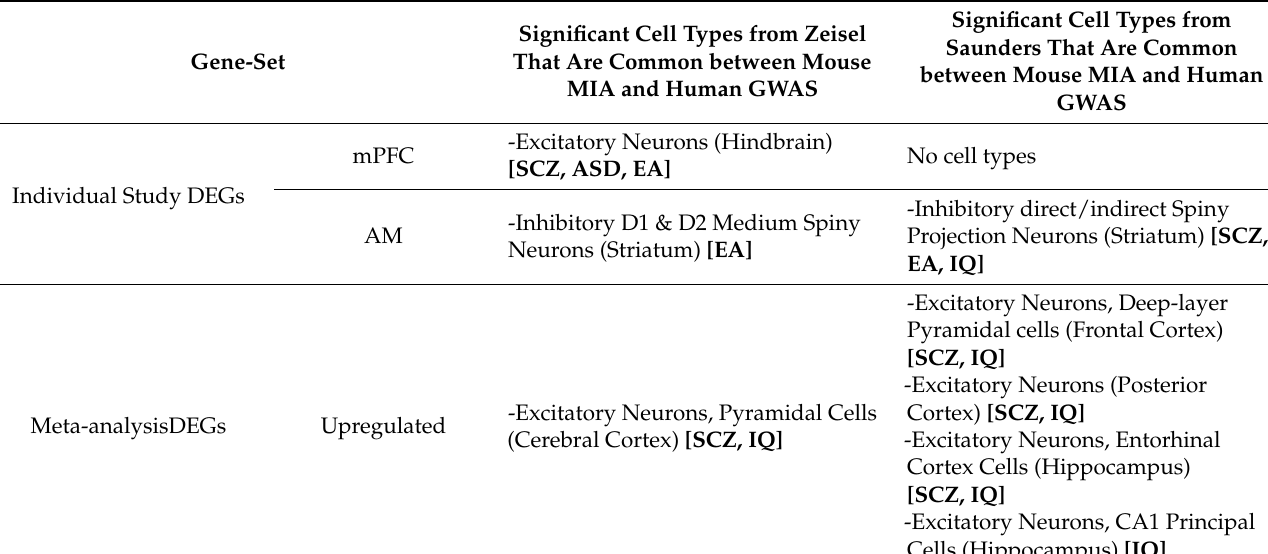
Table 4. Cell types that are enriched for both DEGs from MIA models and genes associated with schizophrenia (SCZ), autism spectrum disorder (ASD), intelligence (IQ) or educational attainment (EA) from genome-wide association studies